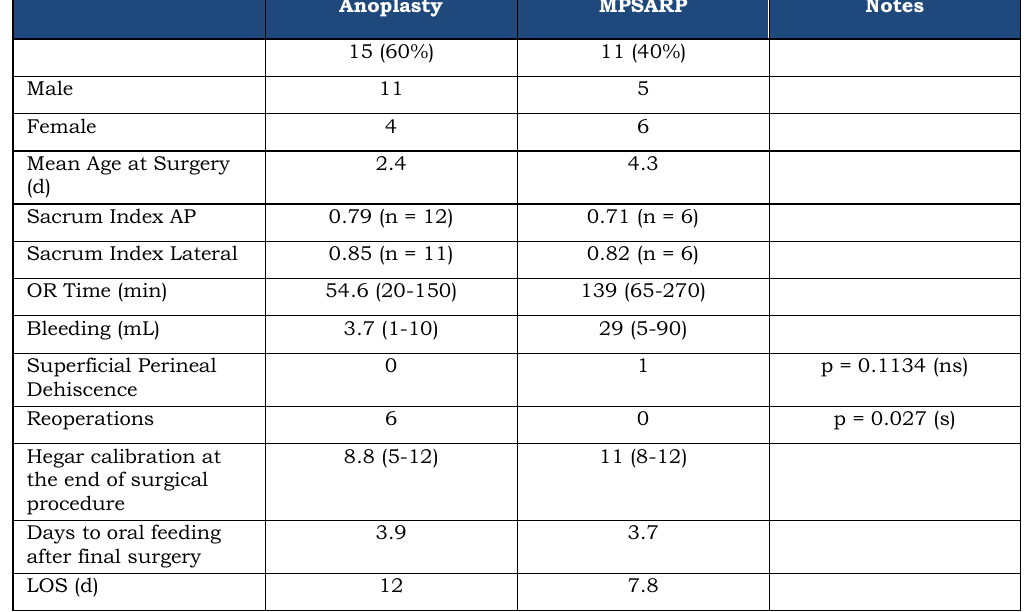
Table 1: Comparison of both